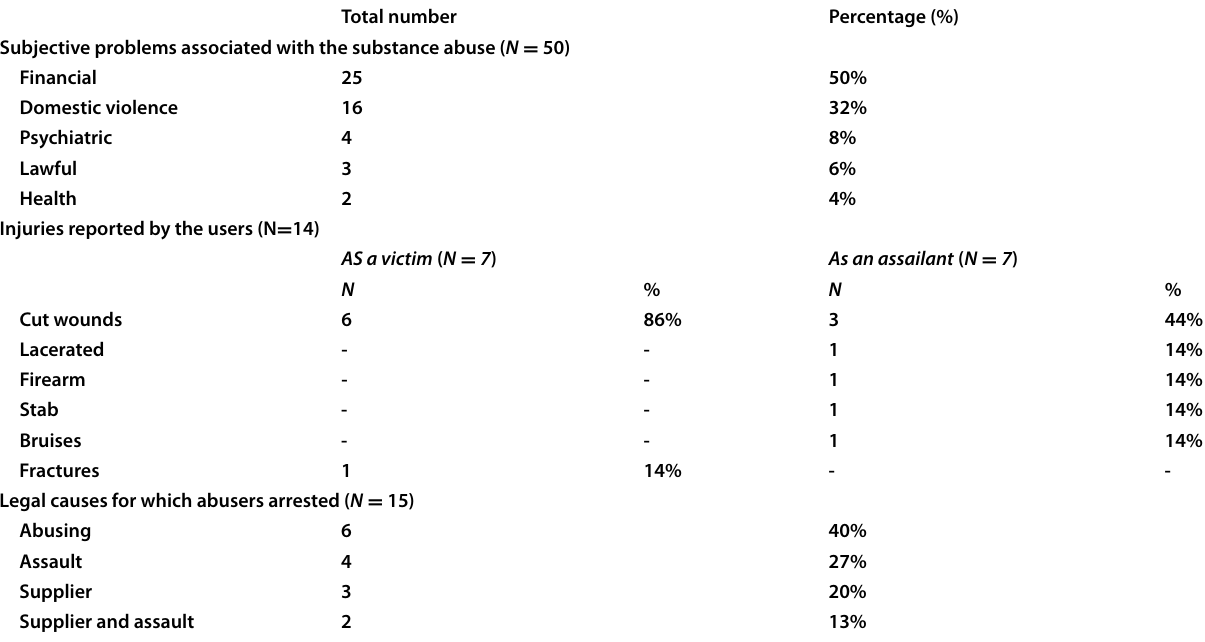
Table 6 Injuries, violence, and problems associated with the drug abusing